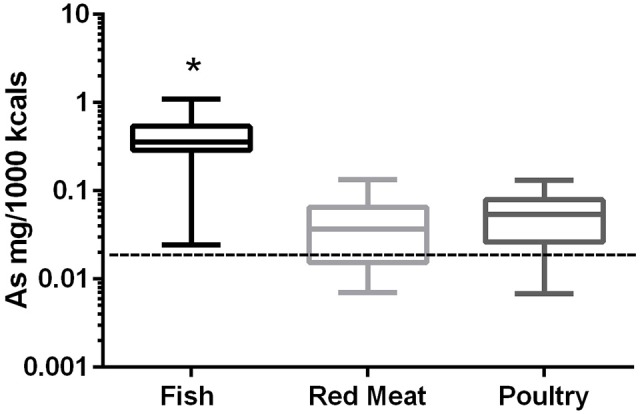
Box-and-whisker plots of the log arsenic concentrations in fish, poultry, and red meat-based dry dog foods (17 dog foods representing each for animal based protein source). Boxes represent the 25 and 75th percentiles, and whiskers represent the minimum and maximum. Solid lines within boxes represent the median values. Dashed lines indicate human intake (mg/Mcal) based on mean daily consumption. *indicates a significant difference from both red meat and poultry based diets (p < 0.01).